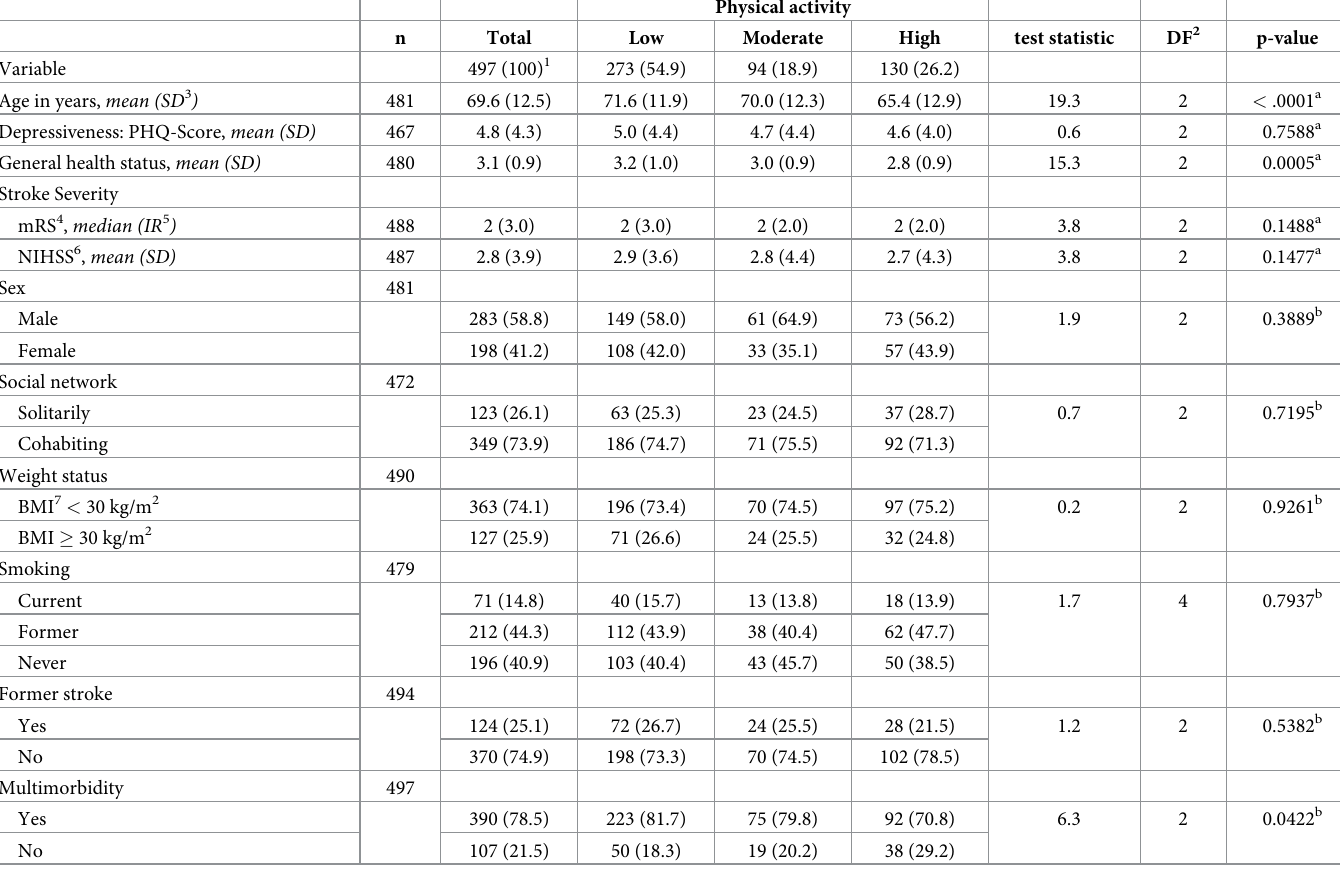
Table 1. Sample characteristics at baseline, overall and stratified by pre-stroke physical